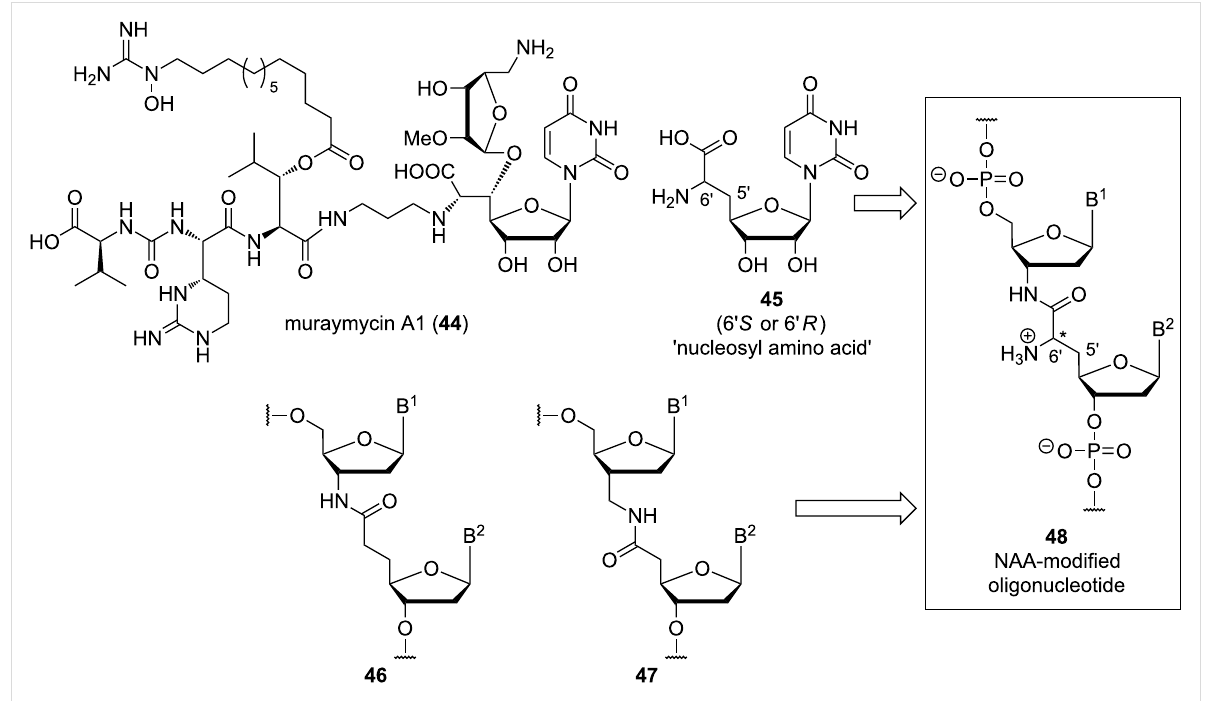
Figure 5: Structure of the natural product muraymycin A1 ( 44 ) and design concept of nucleosyl amino acid (NAA)-modified (partially) zwitterionic oligonucleotides of type 48 formally derived from structures 45 – 47 (B 1 , B 2 = nucleobases).